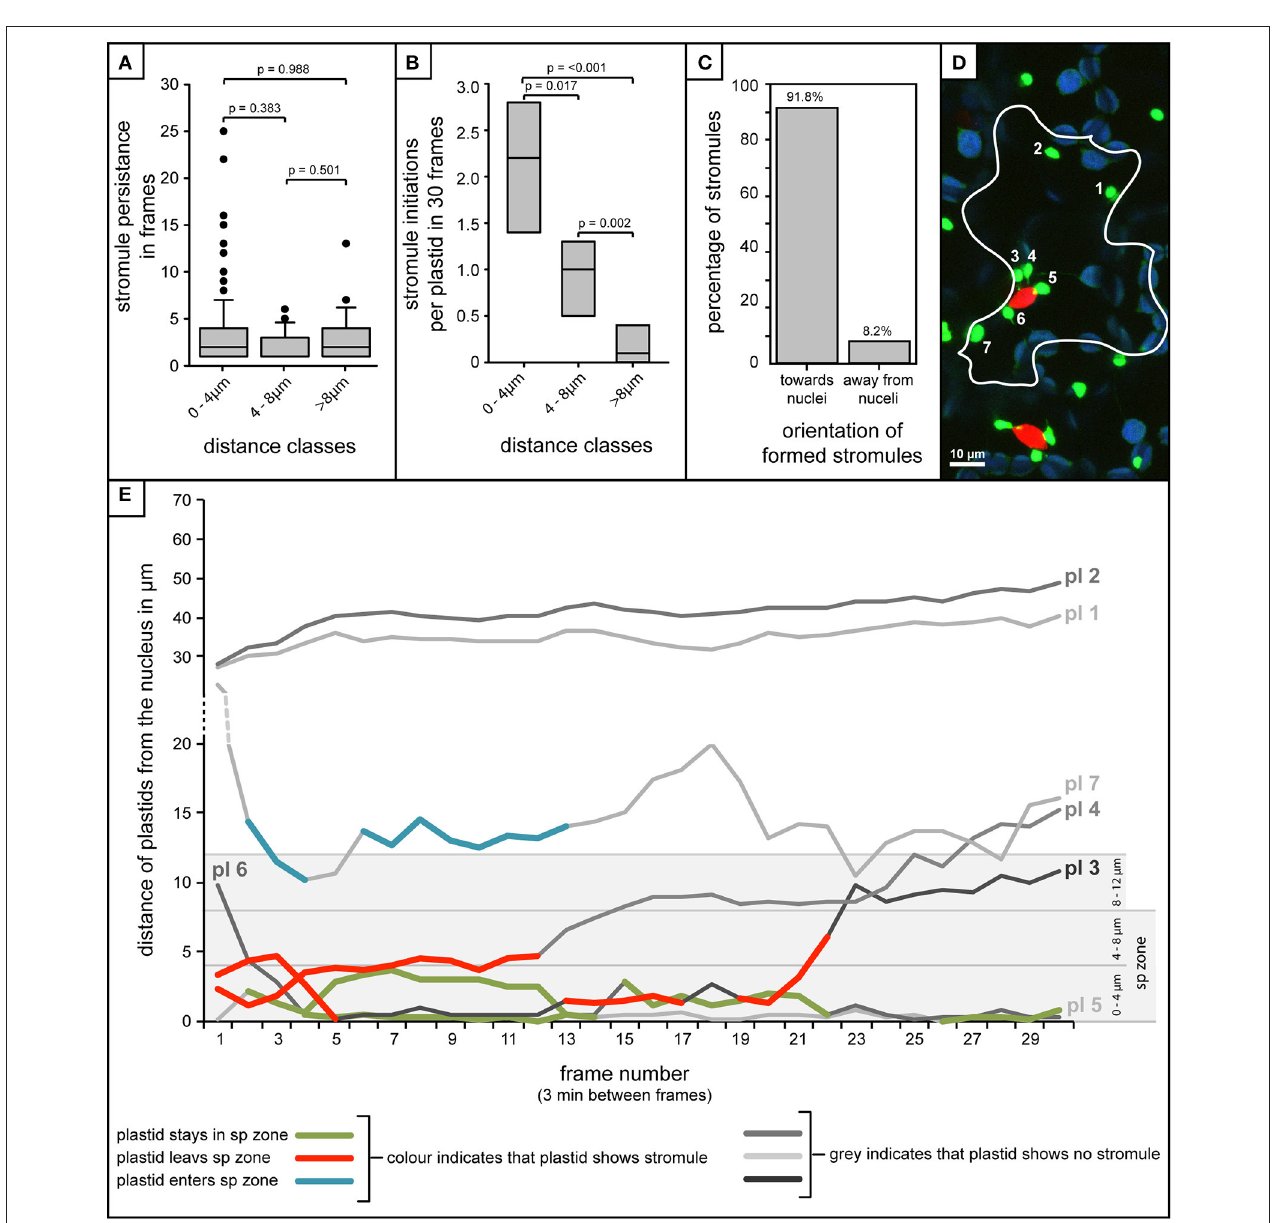
FIGURE 7 | Stromule enrichment in close proximity to the nucleus is due to an increase in formation events, and not to an increase in stromule persistence over time. (A–C,E) Quantification of stromule behavior resulting from the frame-by-frame analysis of 90 min movies (30 frames, 3 min/frame). (A) Box plot showing the persistence of stromules with increasing distance from the nucleus as measure by the number of frames individual stromules persist for. Boxes represent 50% of all data, horizontal line within boxes represents the median, and error bars represent 90th percentile. p -values resulting from Rank-Sum tests comparing treatments can be found above brackets identifying treatments used for comparisons. (B) Box plot representing the number of stromule initiations observed per plastid in each distance class over a period of 90 min ( n = 7 videos). Boxes represent 50% of all data, median is represented by a horizontal line within boxes. p -values resulting from Rank-Sum tests comparing treatments can be found above brackets identifying treatments used for comparison. (C) Percentage of stromules facing toward and away from the nucleus (method for orientation evaluation outlined in Figures 6A,B ). (D) Example of a single frame from a movie with a single cell outlined. Bright green plastids and red nuclei are organelles of the upper epidermis of an A. thaliana wild-type plant transformed with the pLSU4::pn plasmid (blue channel, chlorophyll fluorescence; red channel, H2B:mCherry fluorescence; green channel, FNRtp:eGFP fluorescence). Plastids were assigned numbers to track their identity over the course of the movie (also seen in white). Larger, round, blue signals represent underlying mesophyll plastids, where chlorophyll signal is brighter than the FNRtp:eGFP fluorescence signal. (E) Graph representing the movement of each plastid relative to the nucleus in the cell shown in (D) over the course of 30 frames/90min (Supplementary Movie 1). Each line represents a different plastid (labeled “pl #”), assigned numbers are shown in (D) . Gray scale lines represent frames where the plastid has no stromule, while colored lines represent frames in which stromules are observed. The line with blue segments (pl 8) represents a case where the plastid starts out away from the nucleus, and as it moves closer stromules are initiated, while red lines (pl 3 and pl 4) both illustrate plastids that start close to the nucleus with a stromule, and following movement away from the nucleus they lose their stromule. Green indicates plastids that stay within the “stromule-promoting zone,” initiating one or more stromules over the course of the movie (pl 5 and pl